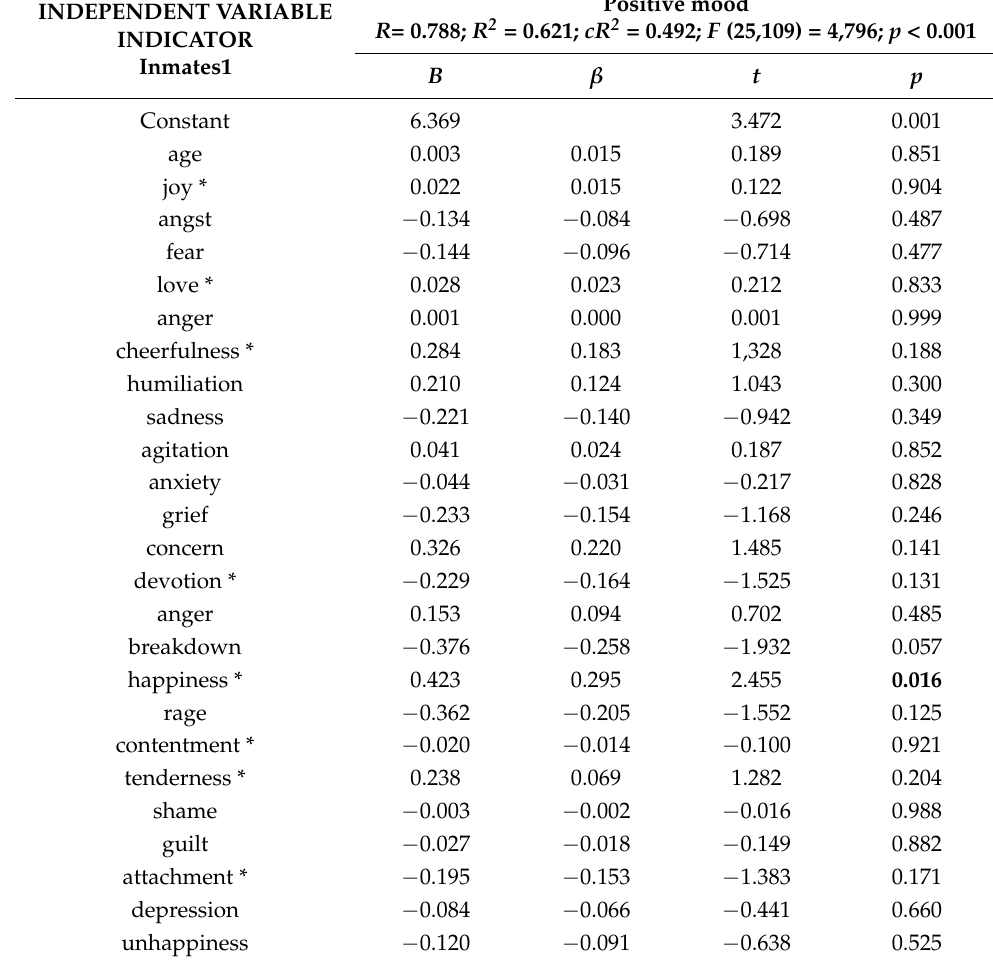
Table 10. Cont. INDEPENDENT VARIABLE